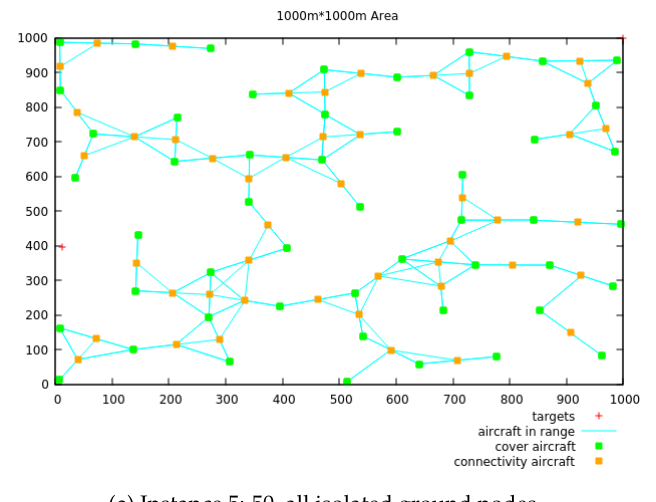
Figure 8. Graphical results for the 5 input tests instances, with p =